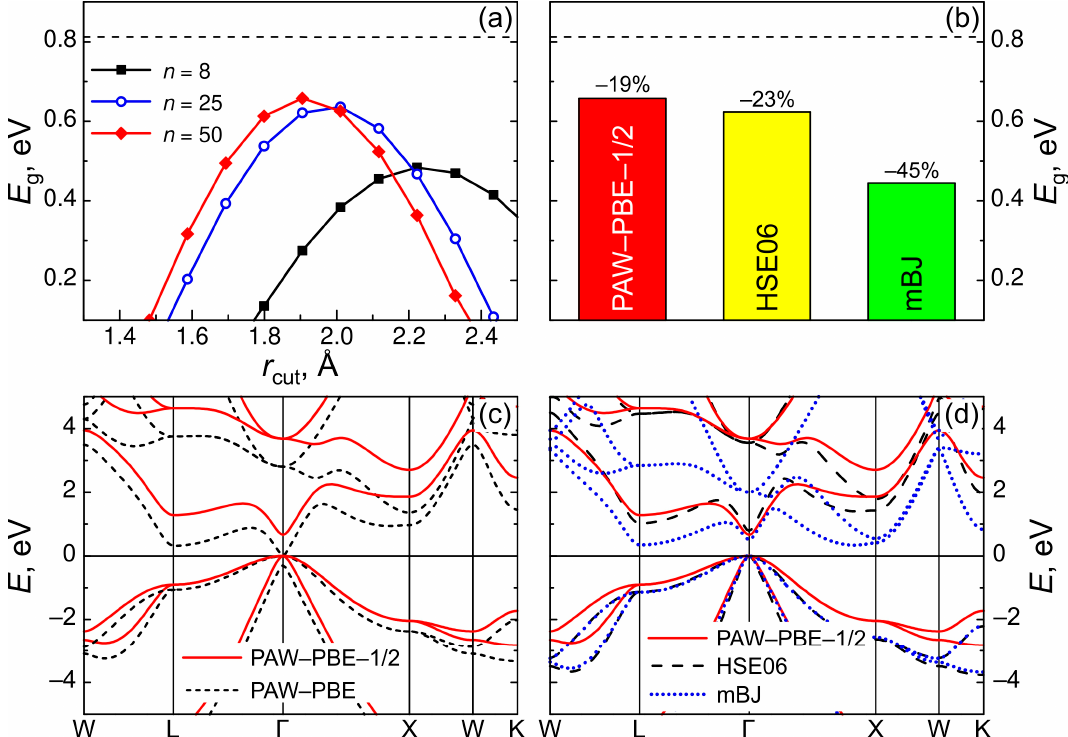
Figure 2. Width of the forbidden gap ( E g ) in bulk semiconductor GaSb depending on the cutoff radius r cut and power index n ( a ); the value of E g for bulk GaSb ( b ) and electron band spectra ( c , d ) obtained by different methods: PAW–PBE–1/2 and PAW–PBE ( c ), and PAW–PBE–1/2, HSE06, and mBJ ( d ). Numbers in ( b ) correspond to underestimation of E g in calculations. The horizontal dotted line in (a,b) shown the experimental value of the forbidden gap width from [32].